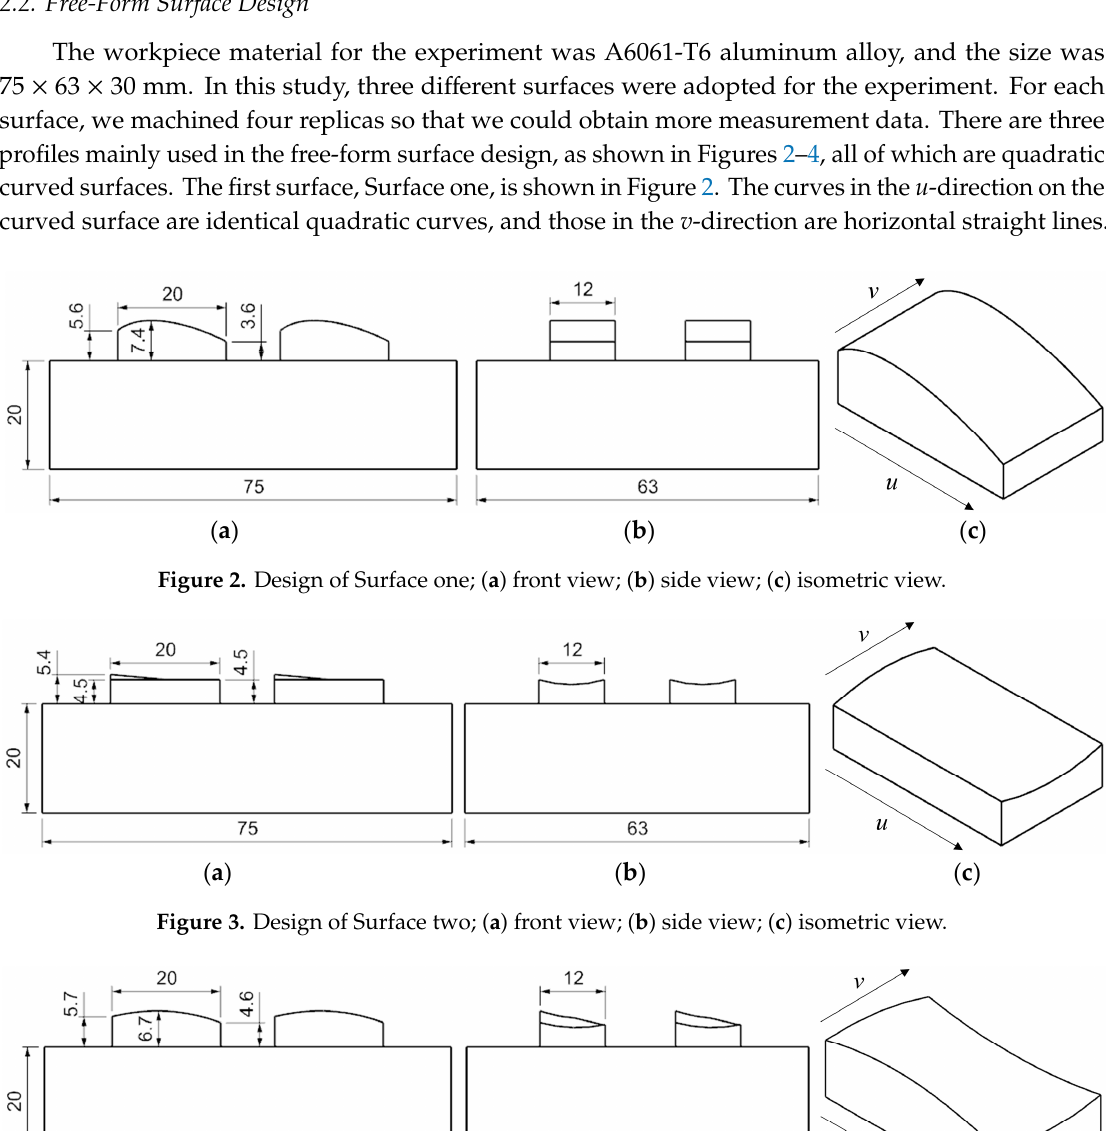
Figure 3. Design of Surface two; ( a ) front view; ( b ) side view; ( c ) isometric view.